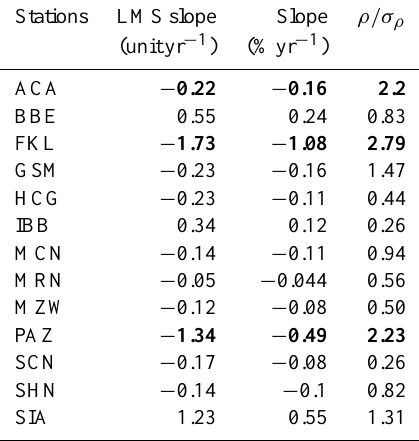
Table 4. LMS trend of the RH percentage measured by the IM- PROVE site Optec nephelometers. The trend are statistically signifi- cant at 95% confidence limit if ρ/σ ρ > 2.00 and at 90% confidence limit if 1.67 <ρ/σ ρ < 2.00.